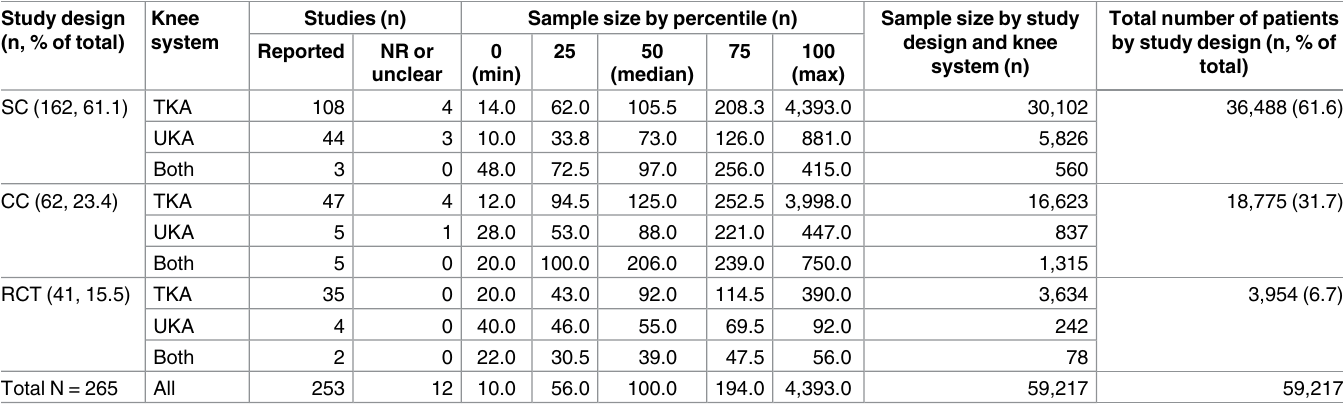
Table 3. Number of patients evaluated in eligible